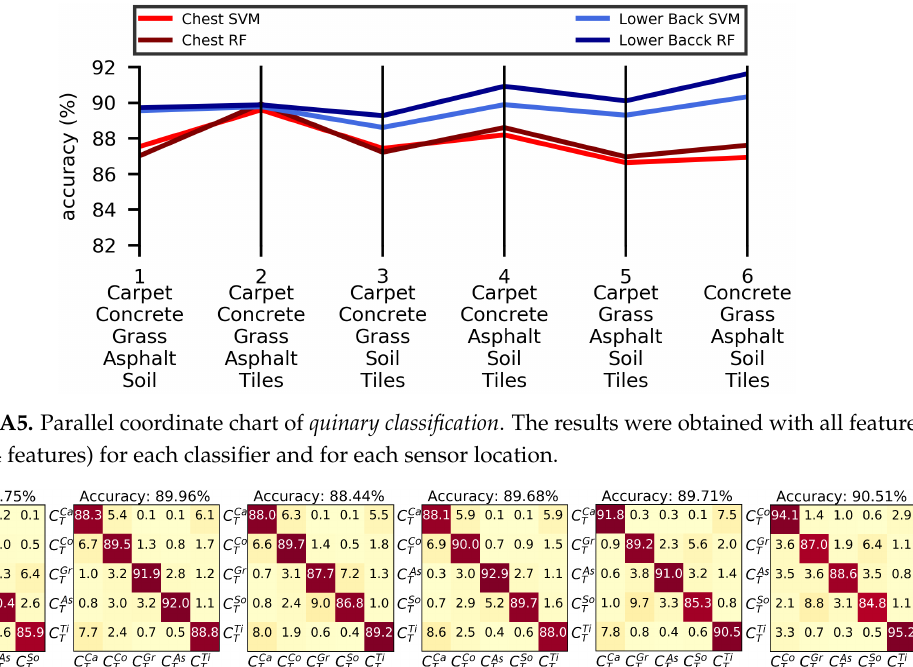
Figure A6. Confusion matrices of quinary classification with lower back sensor. All results were obtained with all features set (194 features) using SVM classifier. Classes: C Ca = grass , C As = Asphalt , C So = soil , and C Ti = tiles C Gr T T T T